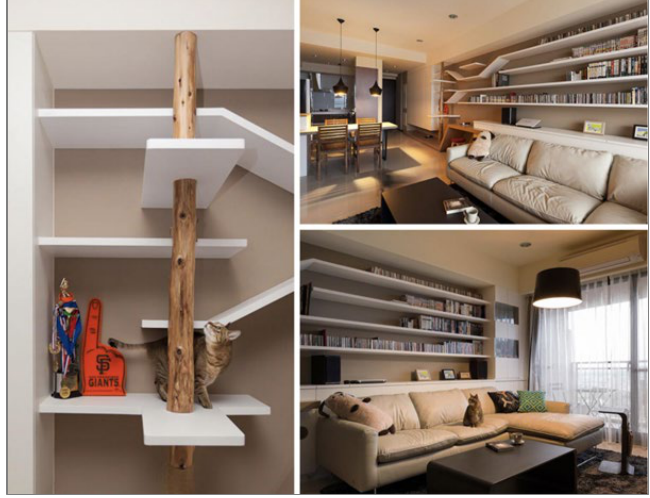
Figure 9 An example of interior space multifunctional wall design